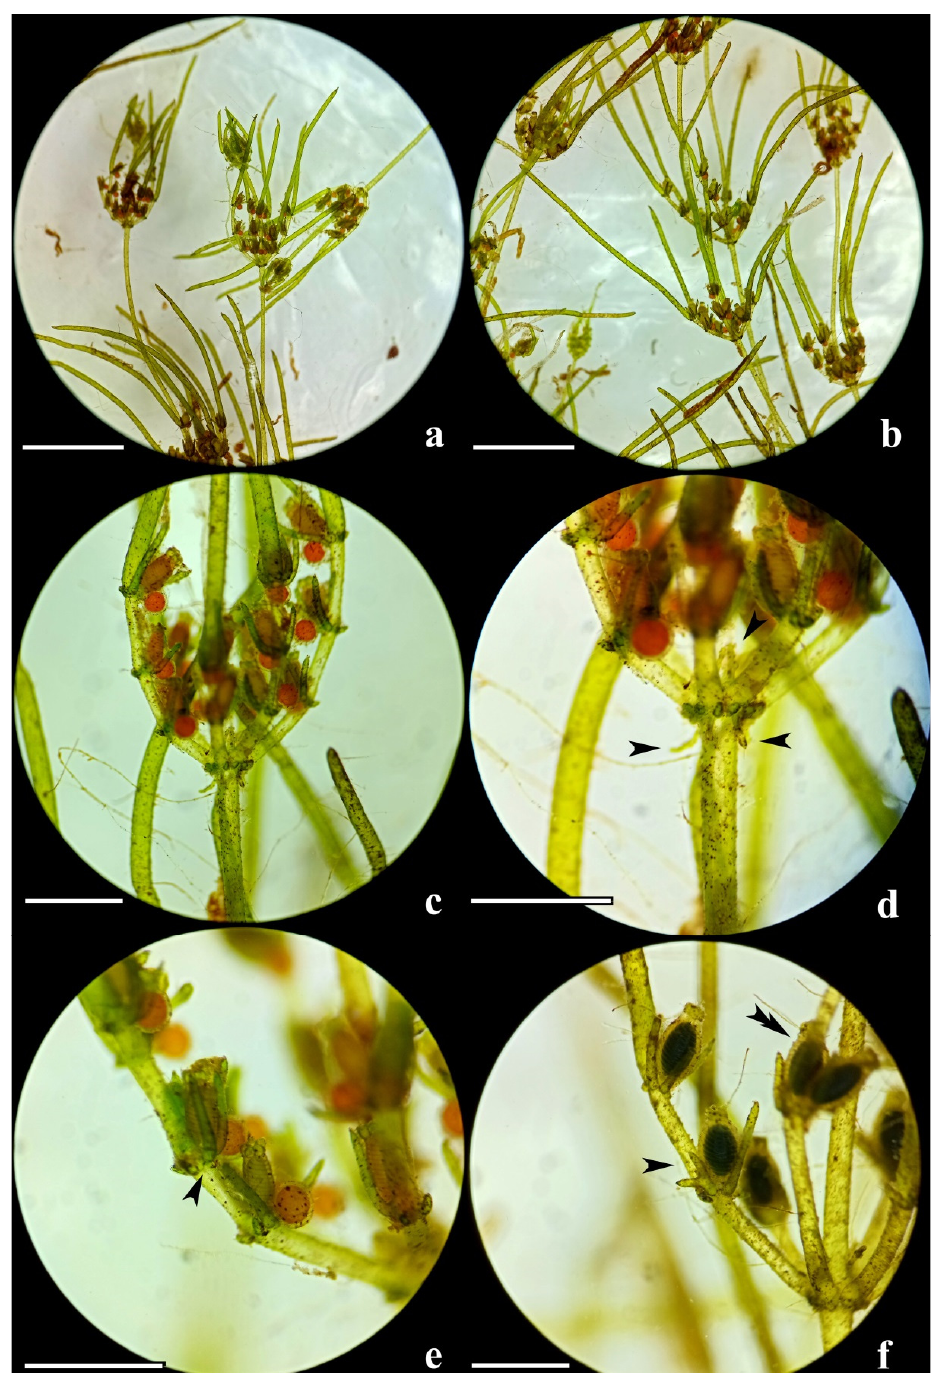
Figure 5. Chara dissoluta from the Gulf of Finland (LE A0003221): ( a )—apical parts showing long ecorticate undifferentiated segments and abbreviated basal segments of branchlets; ( b )—subapical part base of branchlet whorl, showing long ecorticate undifferentiated segments and abbreviated basal segments of branchlets; ( c )—base of branchlet whorl showing short ecorticate basal segments, short bracts, and conjoined gametangia; ( d )—base of branchlet whorl showing slightly elongated upper stipulodes, short primary tubes of stem cortex above and below of stem node peeling of the stem (arrowheads); ( e )—branchlet nodes with conjoined gametangia, short bracts and short initial of branchlet cortex (arrowhead); ( f )—branchlet nodes with ripe oogonia containing ripe black oospores, arrowhead indicates bifid bract cell. Scale: ( a , b )—5 mm, ( c – f )—1 mm. Photos by R.